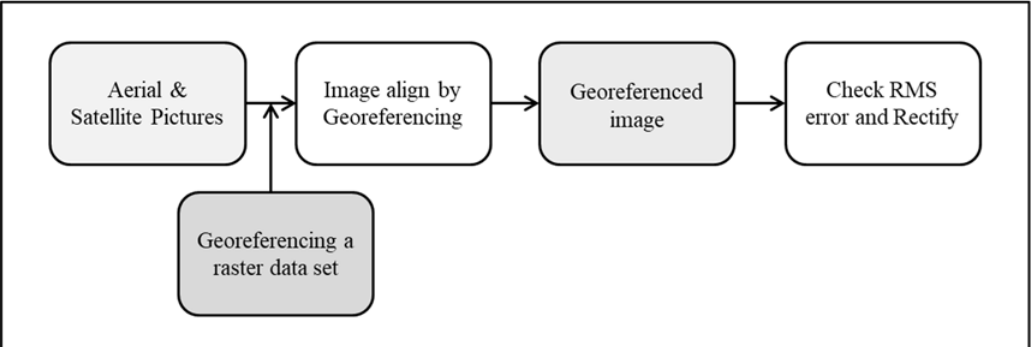
Figure 12. Overlay analysis process.